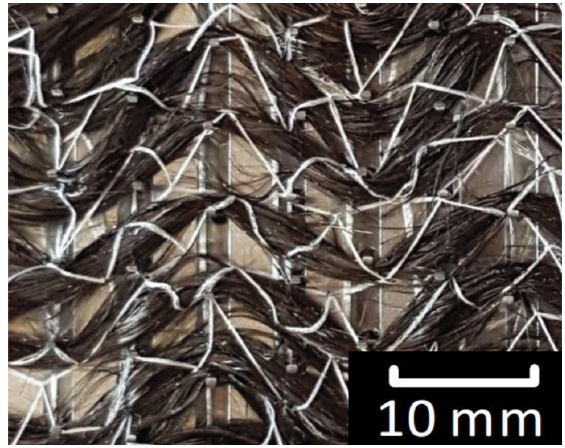
Figure 10. Macro-photography of occurring gaps for wavy samples at an amplitude of